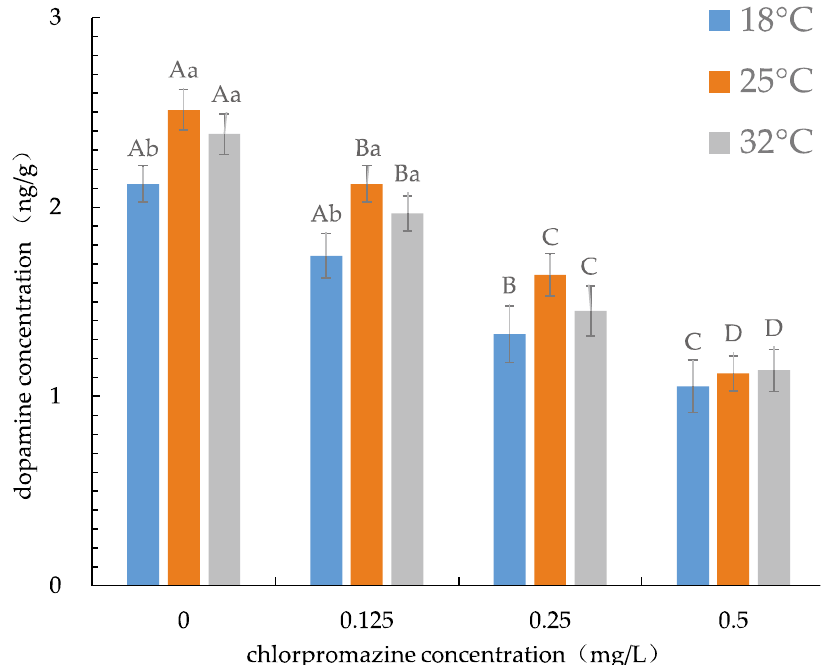
Figure 1. Dopamine concentration of rotifers at different chlorpromazine concentrations and temperatures. Values in each column with different capital letters indicate significant differences among treatments for each temperature ( p < 0.05); column values with different small letters indicate significant differences among treatments for each chlorpromazine hydrochloride concentration ( p < 0.05). CPZ concentration and temperature had a significant effect on rotifer DAC (two-way ANOVA, p < 0.01), but the CPZ × temperature interaction had no effect (two-way ANOVA,